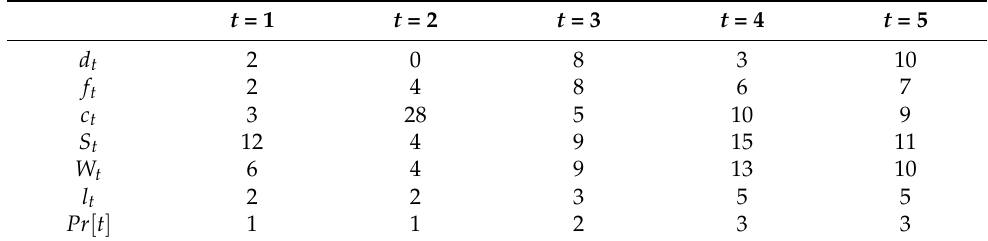
Table 1. Input data.